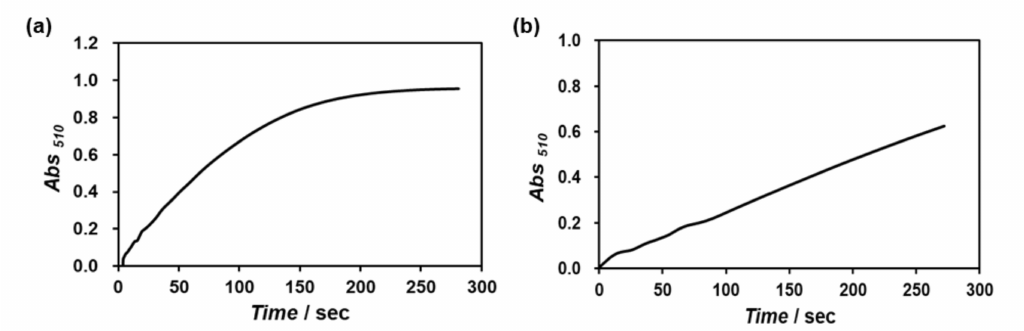
Figure 10. Time courses of absorbance increase at 510 nm due to the enzymatic reaction of ( a ) His-tagged HRP (11.4 µ M) and ( b ) HRP-decorated artificial viral capsid (25 µ M) using 4-aminoantipyrine, phenol, and hydrogen peroxide as substrates in the phosphate bu ff er (pH 7.0) at 25 ◦